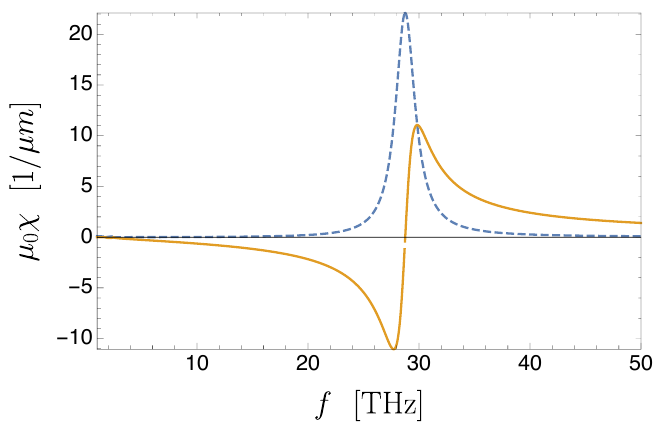
Figure 5. Real (blue dashed line) and imaginary (orange line) of the function µ 0 χ ( ω ) . The parameters of the grating are L = 0.5 µ m and w = L /2. The Fermi energy of graphene is E F = 1 eV. The real part has a pronounced resonance due to the excitation of a surface plasmon polariton of that frequency ( ∼ 87